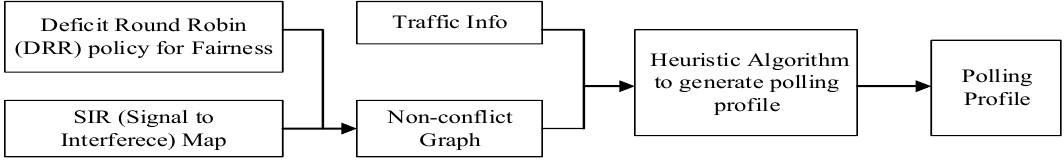
Figure 5. Polling Based Scheduler of pFD-MAC